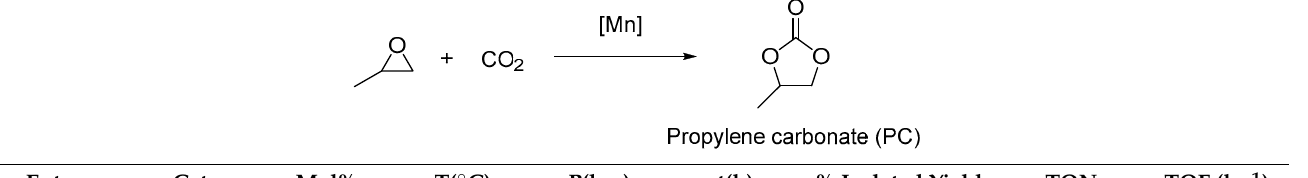
Table 4. Catalytic coupling reactions of propylene oxide and CO 2 with Mn(ONONu) complexes.